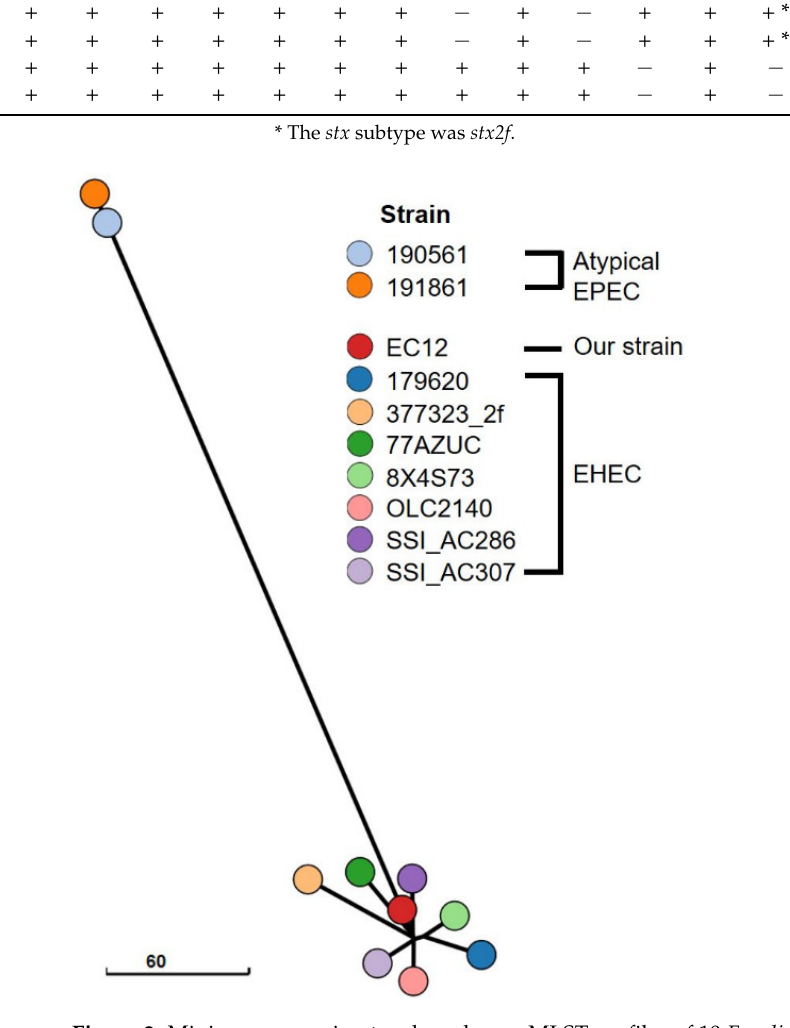
Figure 2. Minimum spanning tree based on cgMLST profiles of 10 E . coli O63:H6 strains included in this study. The branch lengths reflect the number of allelic differences between strains.